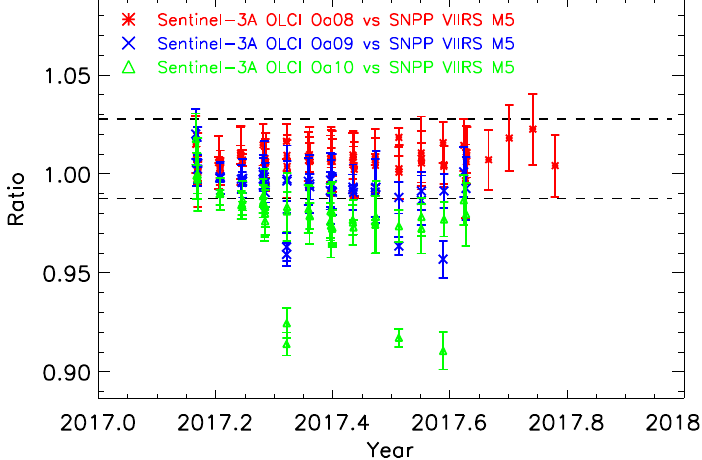
Figure 21. The inter-RSB comparisons of Sentinel Oa08–Oa10 with SNPP VIIRS M5 demonstrating the impact of different level of spectral mismatch. The precision threshold is 3%.